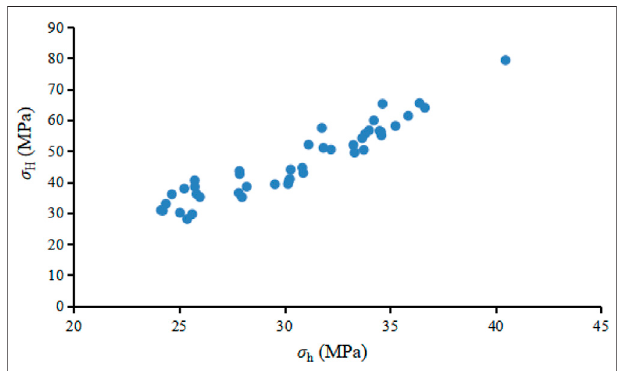
FIGURE 10 | Relationship between the maximum and minimum horizontal principal stresses of the target layer in the study area.